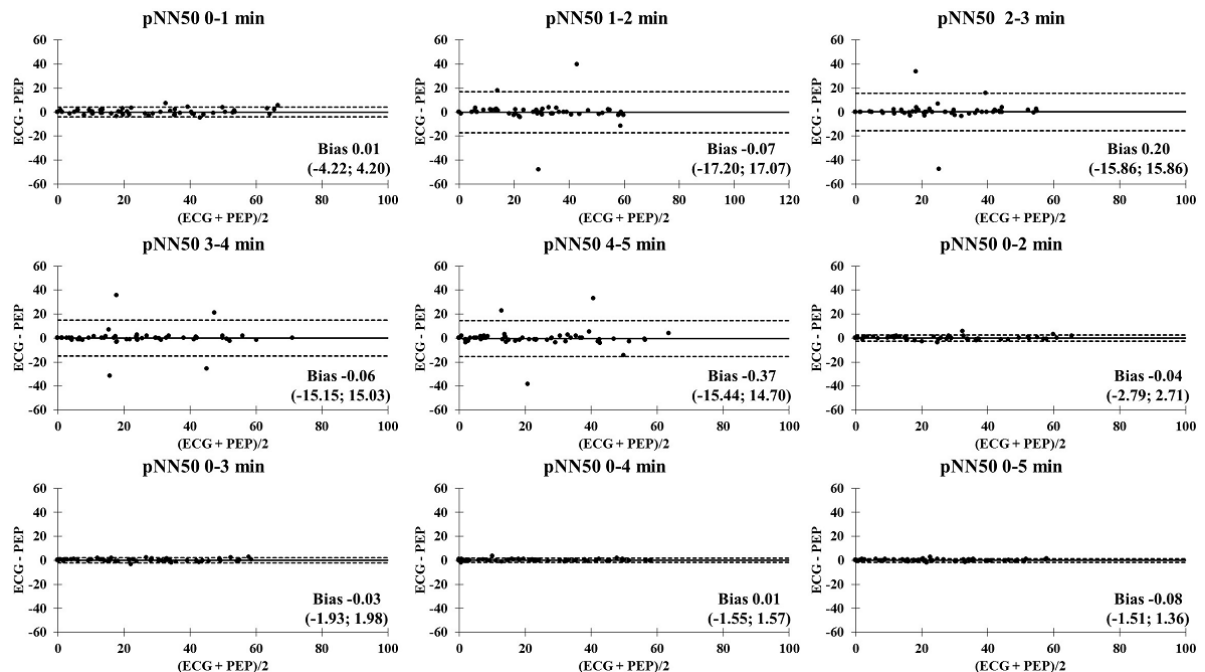
Figure 6. Bland-Altman analysis comparing the ECG and Pulse Express PRO measurements in ultra–short-term and short-term recordings of proportion of NN50 divided by the total number of RR intervals (pNN50). The solid line represents the mean difference and the upper and lower dashed lines represent the upper and lower limits of agreement (± 1.96*SD). ECG: electrocardiogram; PEP: Pulse Express PRO.